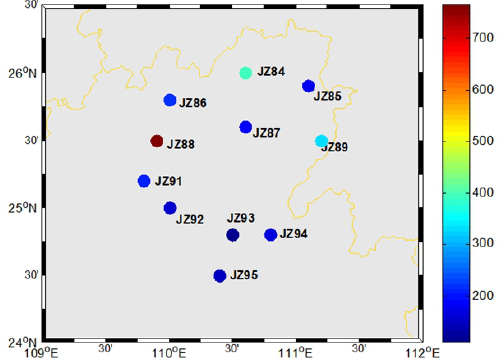
Figure 1 Distribution Map of CORS Stations in Guilin